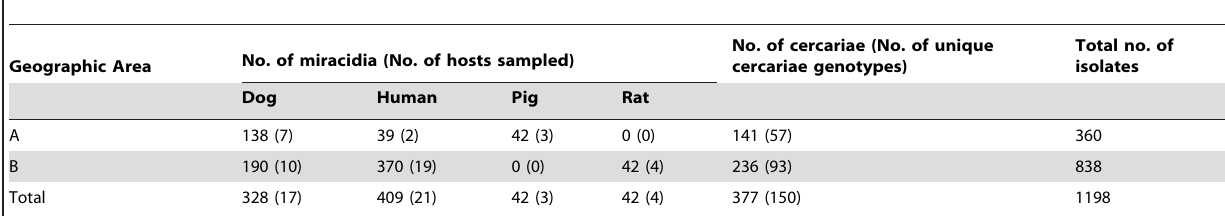
Table 1. Number of Schistosoma japonicum isolates genotyped and number of hosts sampled by geographic area and host